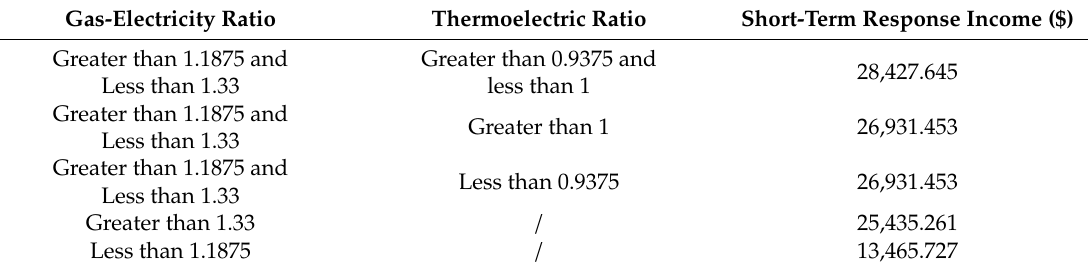
Table 6. Short-term response benefit simulation results.